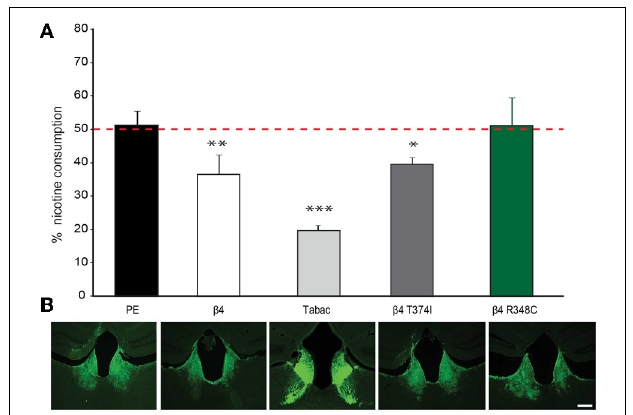
FIGURE 6 | Nicotine intake in mice injected in the Mhb with β 4 and β 4 missense variants. (A) Two-bottle choice nicotine consumption in Tabac mice and in C57BL/6 mice after stereotactic, bilateral MHb injection of lentivirus carrying control (PE), wild-type β 4 or β 4 containing the R348C or T374I mutations constructs ( n = 6–8 mice per group). All values are expressed as mean ± s.e.m. One-Way ANOVA F ( 4 , 29 ) = 25 . 25, p < 0 . 0001; Dunnett’s Multiple Comparison post-hoc ∗ p < 0 . 05, ∗∗ p < 0 . 01, ∗∗∗ p < 0 . 001. (B) Representative images of coronal brain sections showing the site of lentivirus injection in MHb for PE, β 4T374I, and β 4R348C in C57BL/6 mice or eGFP expression in the MHb and fasciculus retroflexus in Tabac transgenic